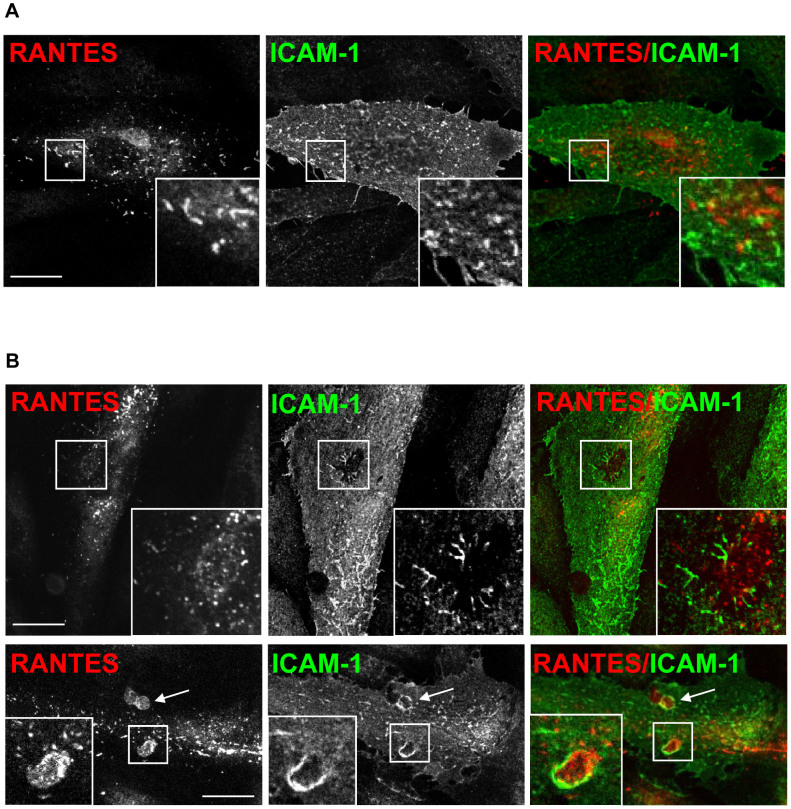
RANTES shows distinct localization from that of ICAM-1.(A) Localization of RANTES compared to that of ICAM-1 after electroporation
of HUVECs with plasmid DNA encoding wtRANTES and stimulation with TNFα
before fixation, permeabilization and immunolabelling. Corner insets show
high magnification of framed areas. Scale bar, 10 μm. (B) HUVECs
were treated as indicated in (A) before incubation with MCP-1, followed by
addition of peripheral blood mononuclear cells for 20 min followed by
fixation, permeabilization, and immunolabelling. Corner insets show high
magnification of framed areas, which are areas where one leukocyte has
transmigrated. Arrows in the lower panel indicate two leukocytes that may
have transmigrated. Original magnification in all panels, × 100. Scale
bars, 10 μm. A rabbit anti-RANTES antibody was utilized in
immunolabelling of RANTES. All samples were analyzed by use of sequential
scanning confocal microscopy.